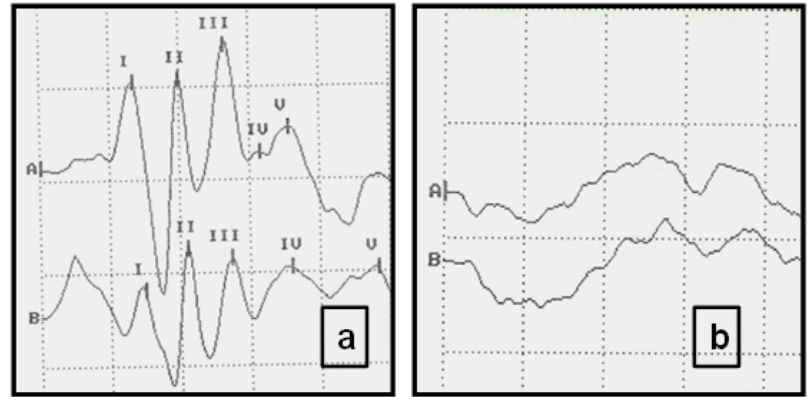
Figure 3. Typical visual evoked potentials (VEP) and auditory evoked potentials (AEP) of study cats displaying normal and abnormal registers. ( a ) Normal AEP in a cat. Intensity